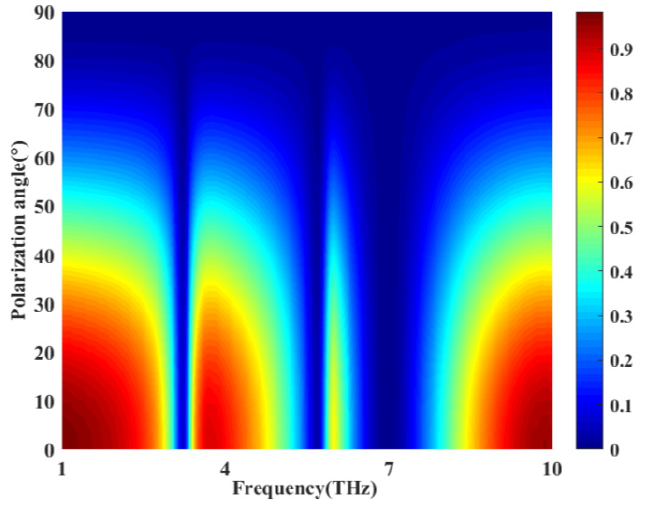
Figure 13. The transmission efficiency of the proposed structure for different polarization angles in the frequency range of 1–10 THz.